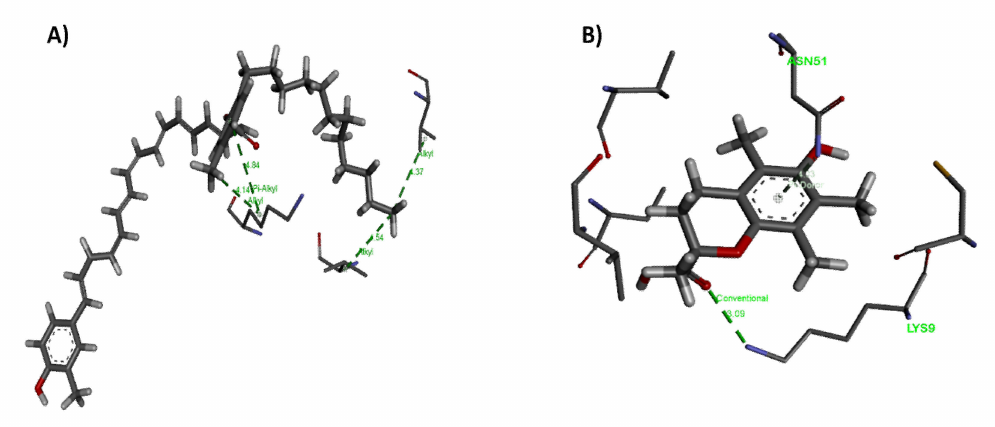
Figure 8. Different bond distances of ( A ) Flexirubin and ( B ) Trolox with Cu/Zn superoxide dismutase enzyme generated by BIOVIA discovery studio visualizer (version 19).